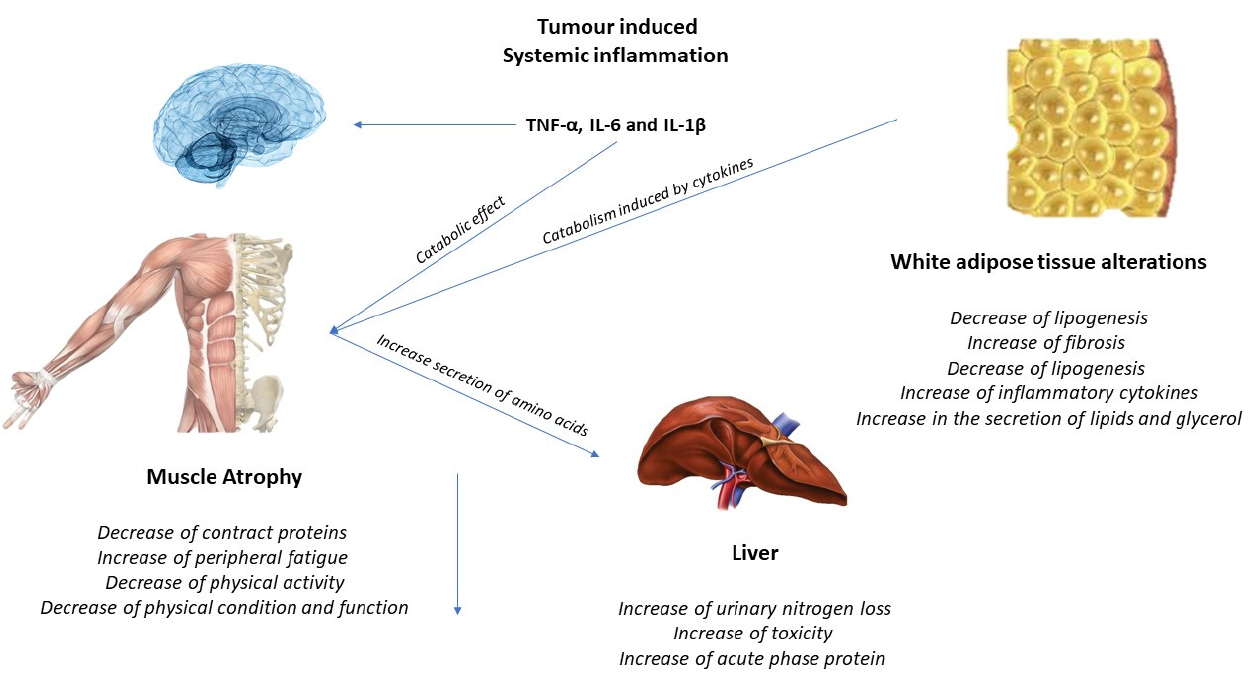
Figure 2. Tumor-induced systemic inflammation.